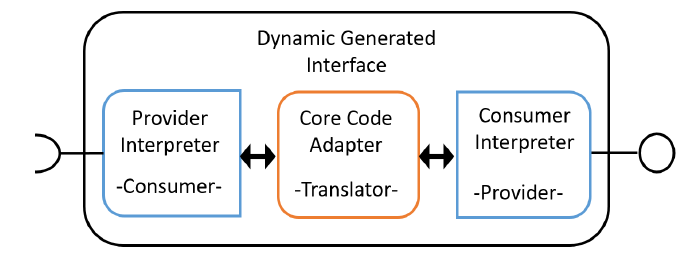
Figure 3. Block description of the internal parts of the dynamically generated